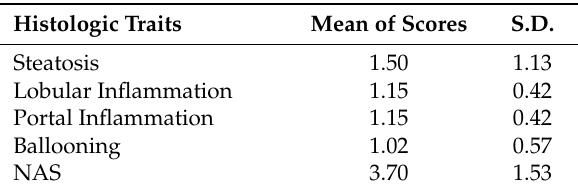
Table 2. Histological features of patients ( n =